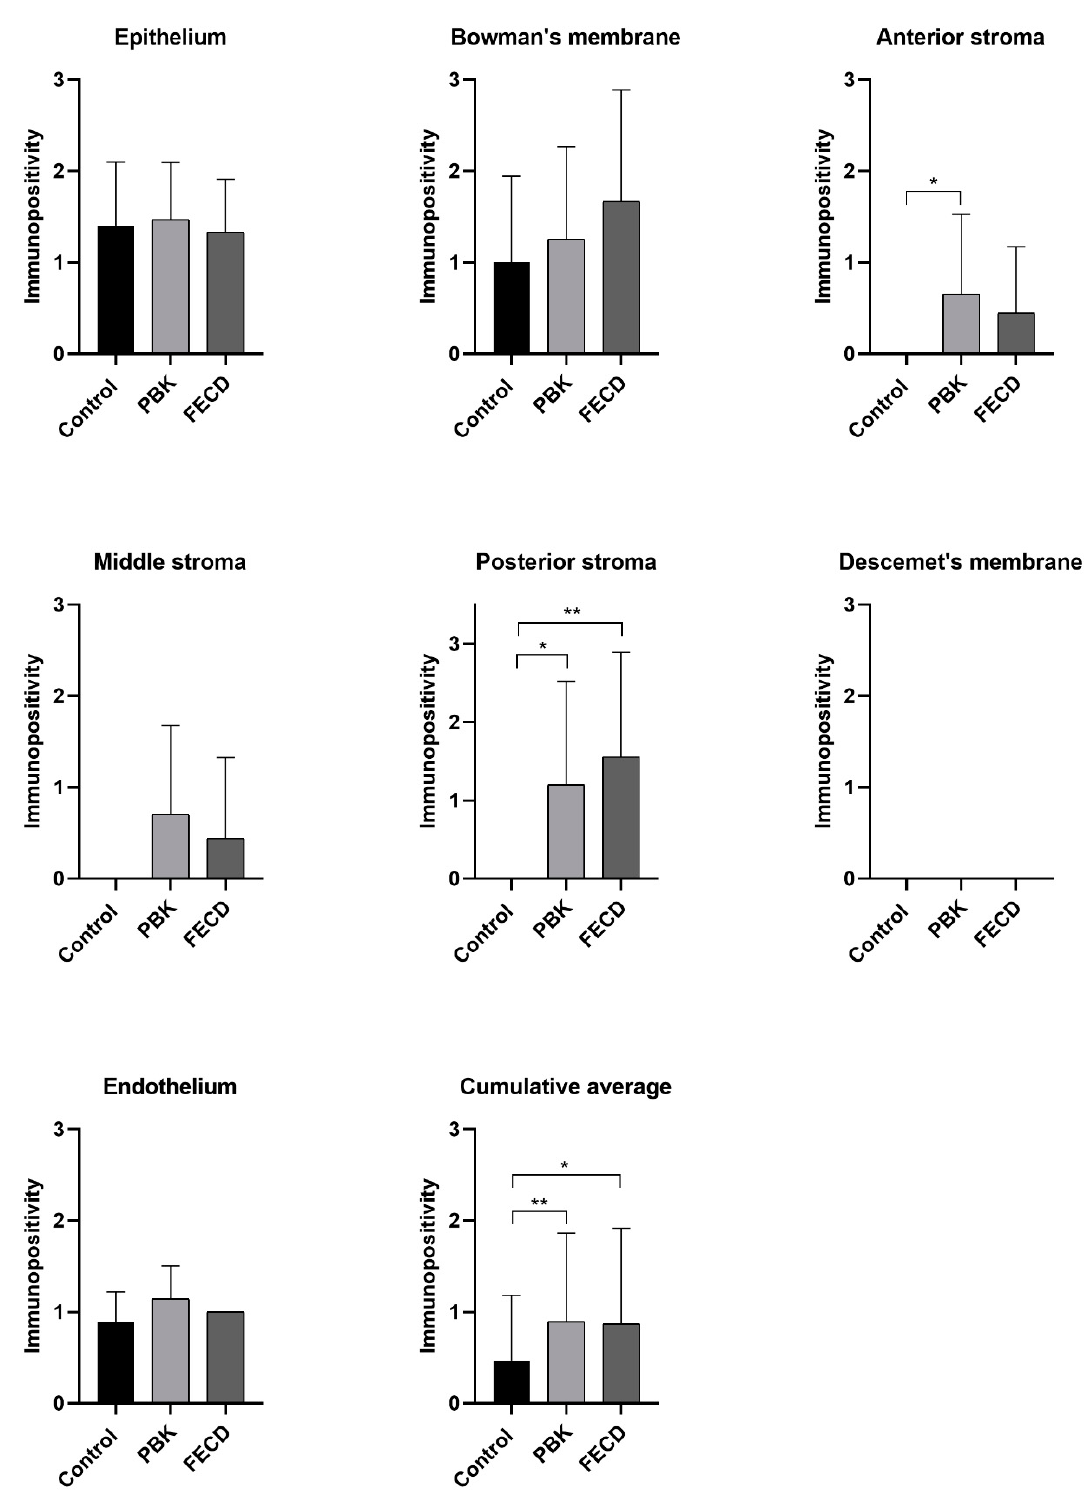
Figure 3. The average aggrecan immunopositivity in the different corneal layers in normal and pathologic conditions. PBK = pseudophakic bullous keratopathy, FECD = Fuchs’ endothelial corneal dystrophy. Columns indicate the average immunopositivity (0 means no staining, 0.5+ minimal, 1+ mild, 2+ moderate, 3+ marked positivity). * = level of significance ( p ˂ 0.05 *; p ˂ 0.01 **). In PBK and FECD, the epithelium and Bowman’s membrane disclosed mild